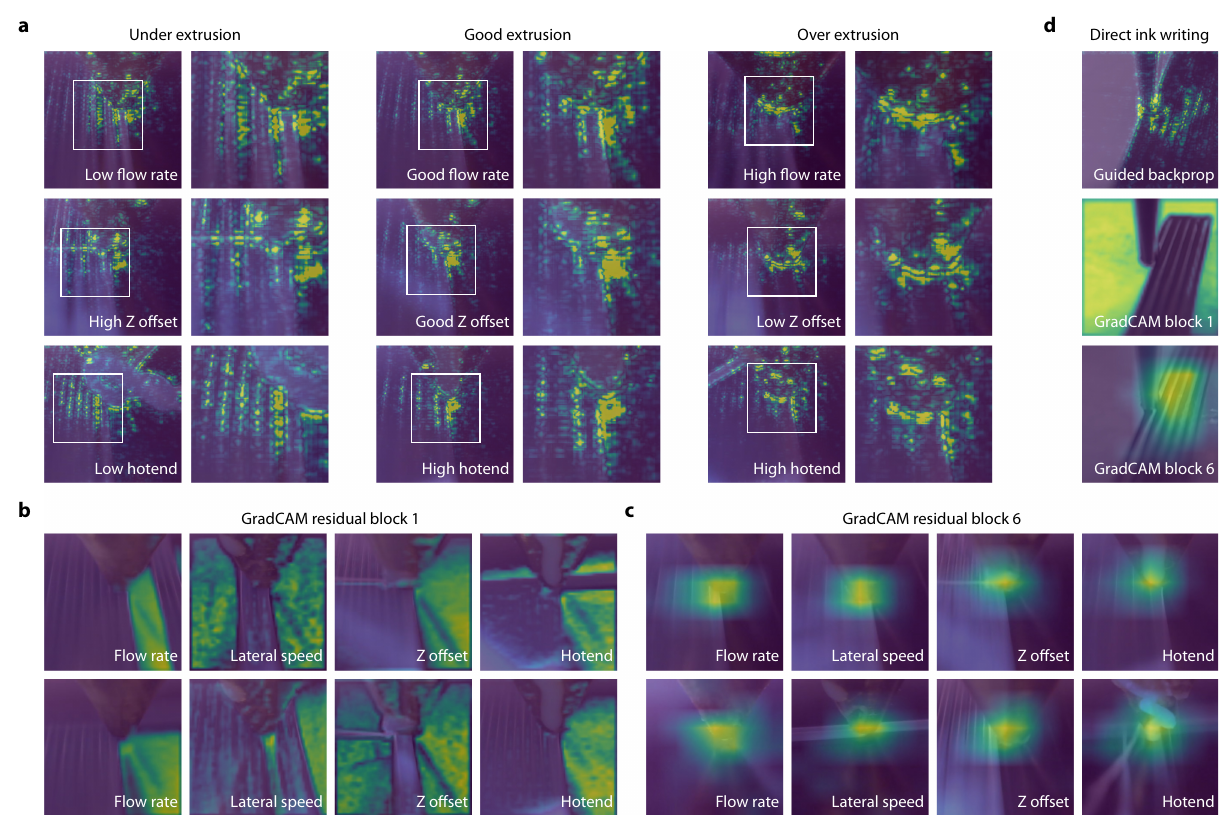
Fig. 6 | Visual explanations using separate saliency maps for each parameter may assist in verifying the robustness of the network. a Under, good or over extrusion can be achieved by multiple incorrect parameters. Guided backpropagation 59 is applied to highlight important features in the image used forclassi fi cation. Representative exampleunseen imagessuggest that the network uses similar features across parameters to identify the same physical property. b Gradient-weighted Class Activation Mapping (GradCAM) 60 shows that across